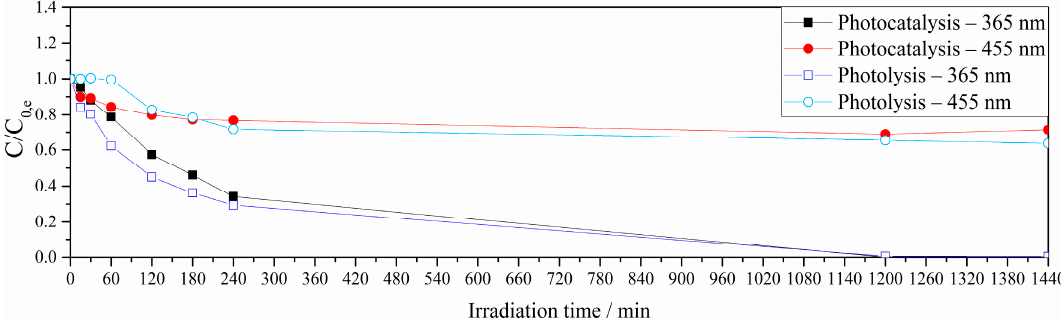
Figure 4. Long term photocatalytic and photolytic conversion of chlorpromazine sulfoxide (SFX) (100 µ M) upon UV(A) and visible light irradiation using K-7000 as photocatalyst (1 g L − 1 ).